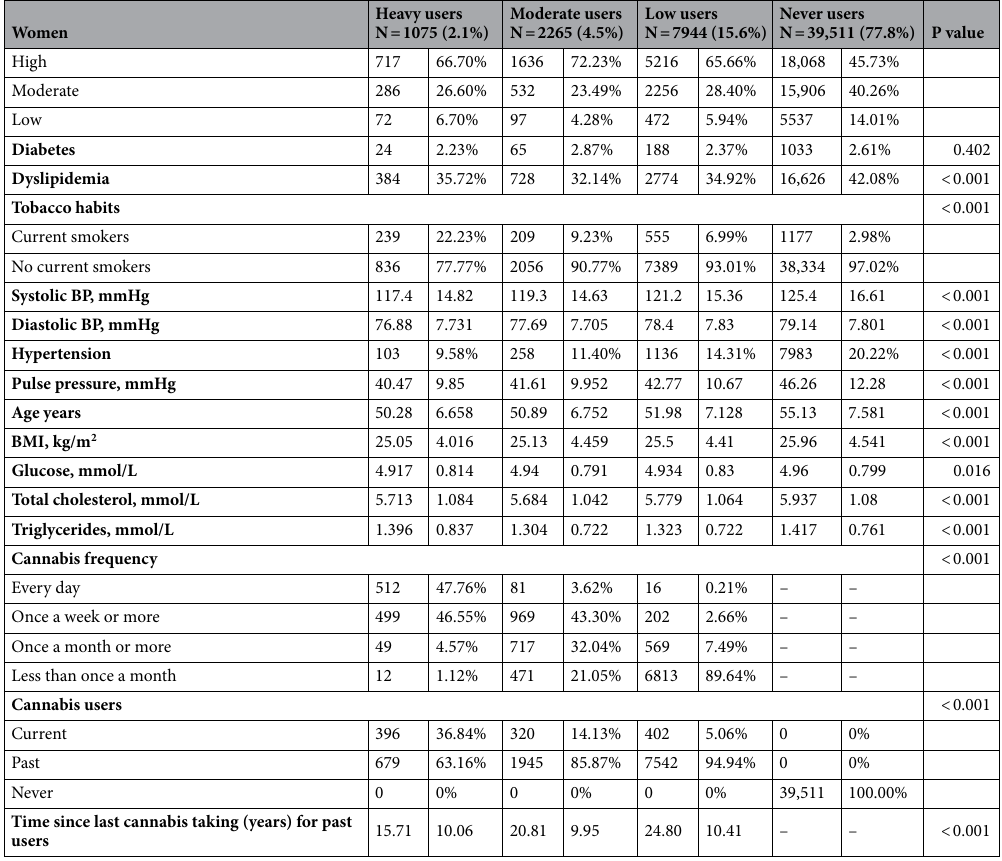
Table 1. Characteristics of the study population according to gender and cannabis use status [categorical variables with n and percentages, continuous variables with mean and standard deviation (SD)]. BMI: